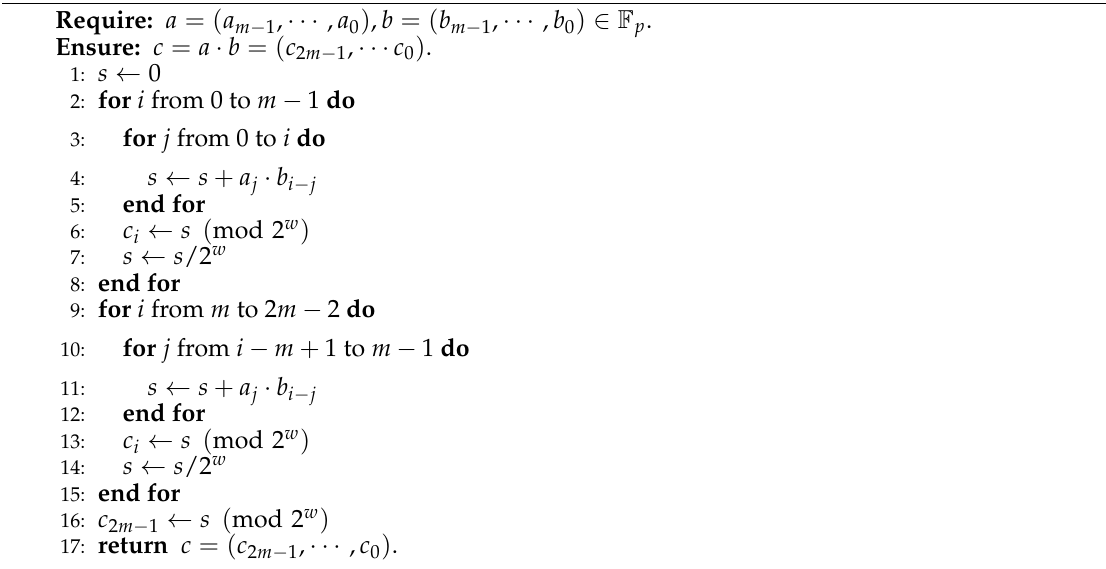
Algorithm 5: Product scanning